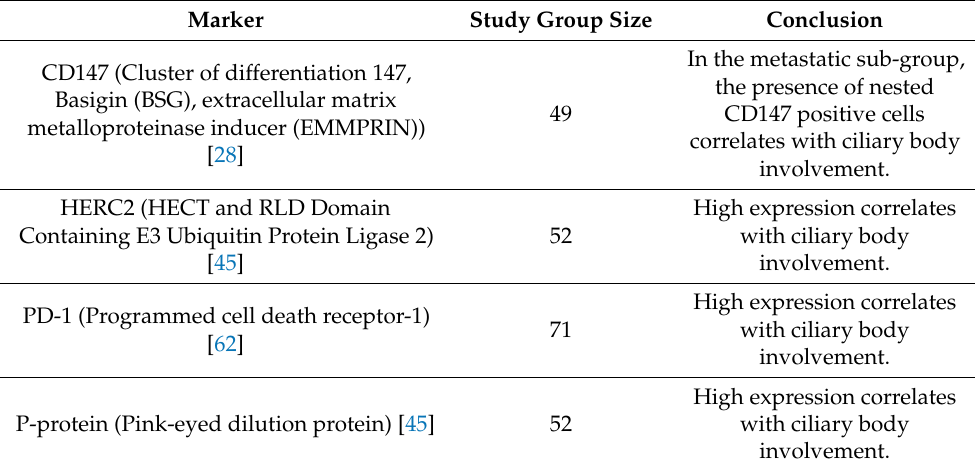
Table 3. Summary of markers whose expression is related to ciliary body involvement. Marker Study Group Size Conclusion